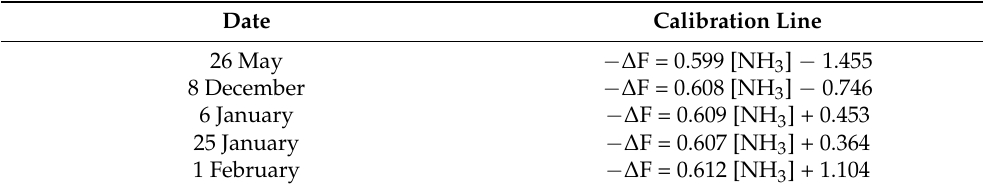
Table 1. Calibration lines obtained for the same sensor, along 8